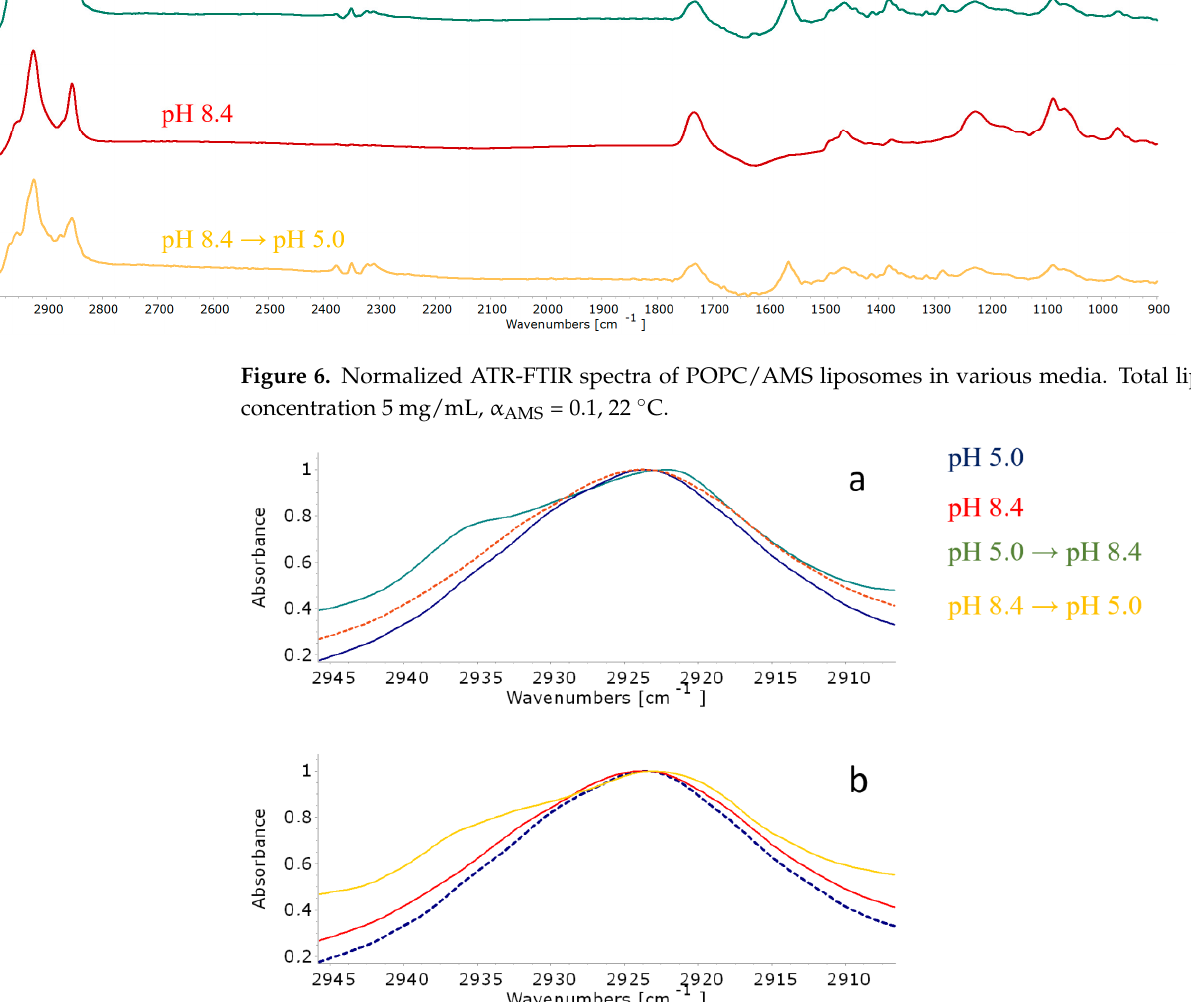
Figure 6. Normalized ATR-FTIR spectra of POPC/AMS liposomes in various media. Total lipid con- centration 5 mg/mL , α AMS = 0.1, 22 °C.